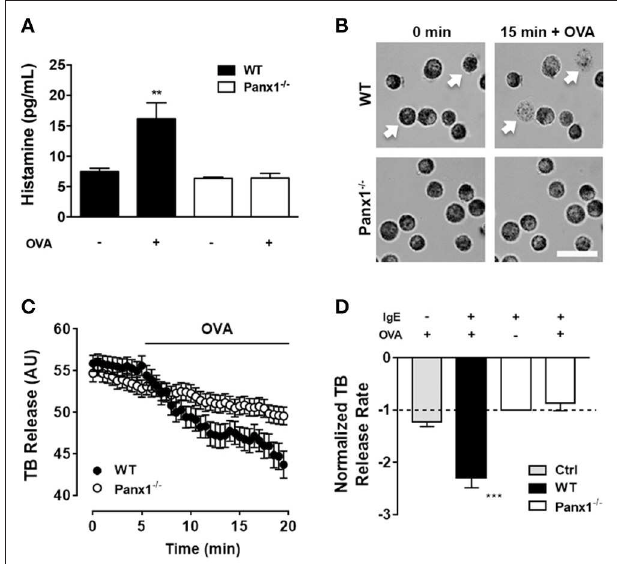
FIGURE 1 | Degranulation induced by OVA cross-linked recognition depends on Panx1 expression. (A) Extracellular histamine concentration in IgE-sensitized mast cells (MCs) cultured under basal conditions and after 20min stimulation with 10 µ M OVA in wild type (WT, black) and Panx1 − / − mast cells (MCs) (white). (B) Representative images of toluidine blue (TB)-loaded WT (upper panels) and Panx1 − / − MCs (lower panels) before and after 15min treatment with 10 µ M OVA. White bar: 20 µ m. (C) Time-lapse measurements of blue intensity recorded in WT (black circles) and Panx1 − / − (white circles) MCs before and after treatment with OVA (black trace). (D) Normalized blue intensity loss rate induced by OVA with respect to basal conditions in control non-sensitized MCs (Ctrl, gray), WT (black), and Panx1 − / − MCs (white). Each point corresponds to the mean ± SEM, n = 4, between 30 and 50 cells were recorded in each experiment, *** p < 0.0005; ** p <